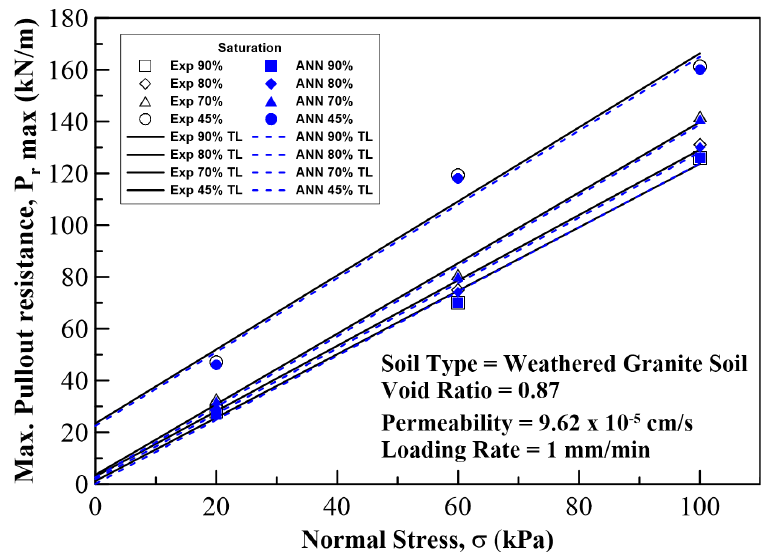
Figure 13. Maximum pullout resistance vs. normal stress relationship for 45%, 70%, 80%, and 90%